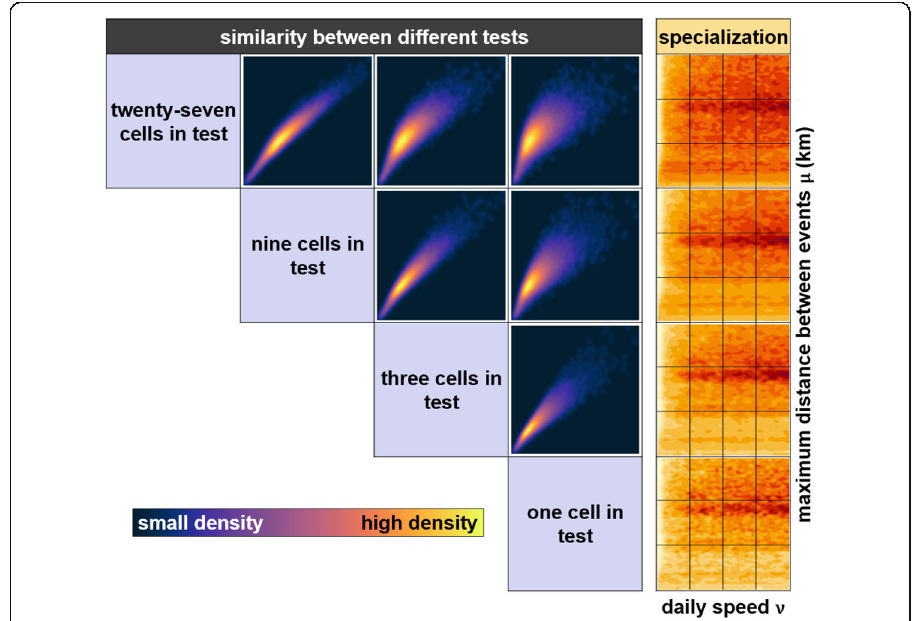
Fig. 10 The average metric of specialisation under different values of the daily speed ν and the maximum distance μ according to the number of cells which are considered for the